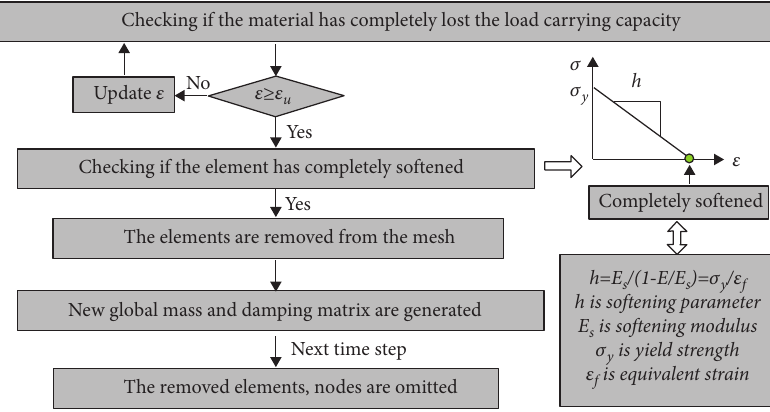
Figure 6: Element deletion (erosion) technology flowchart.